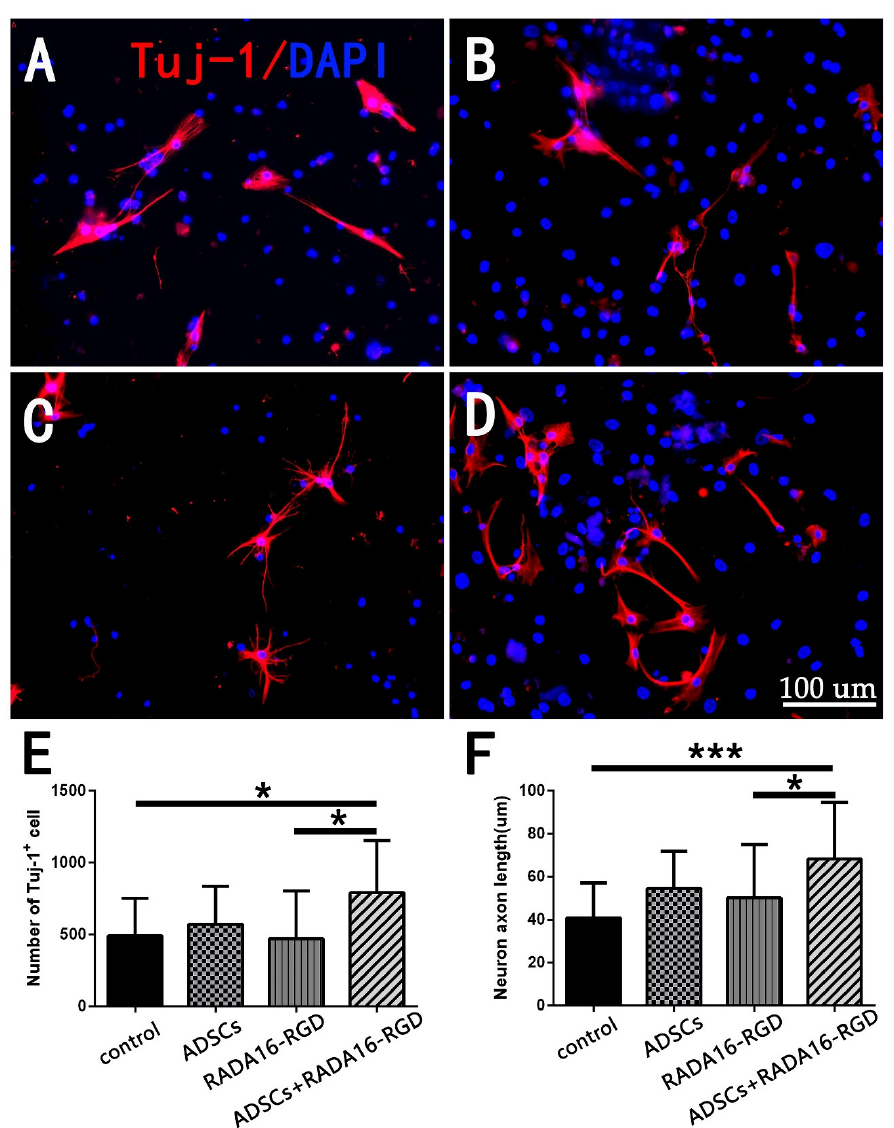
Figure 1. Detection of the numbers and neurite lengths of cultured TUJ-1 + spinal cord neurons. TUJ-1 antibody staining after culturing neurons for 7 days. ( A ) Control group. ( B ) RADA16-RGD group. ( C ) ADSCs group. ( D ) ADSCs+RADA16-RGD group. ( E ) The number of TUJ-1 + neurons in the ADSCs+RADA16-RGD group was significantly greater than that in the control or RADA16-RGD groups (ADSCs+RADA16-RGD vs. control or RADA16-RGD: p < 0.05); however, there was no significant difference between the ADSCs and ADSCs+RADA16-RGD groups ( p > 0.05), and the control, ADSCs, and the RADA16-RGD groups showed no significance ( p > 0.05). ( F ) The axonal lengths in the ADSCs+RADA16-RGD group were significantly greater than in the control or RADA16- RGD groups (ADSCs+RADA16-RGD vs. control or RADA16-RGD: p < 0.05); however, there was no significant difference between the ADSCs and ADSCs+RADA16-RGD groups ( p > 0.05), and the control, ADSCs, and the RADA16-RGD groups showed no significance ( p > 0.05). Data are presented as the mean ± SEM ( n = 4 per group). Scale bar = 100 µ m. * p < 0.05, *** p < 0.001. TUJ-1: β